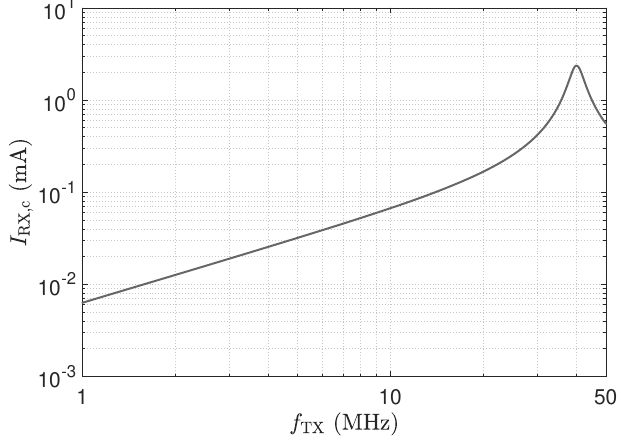
Figure 7. Frequency response of the current for the LCR input stage shown in Figure 4c. Component values stated in [30] were used to obtain a resonant frequency of 40MHz. The LCR circuit has a quality factor Q of 9.6. An excitation voltage V TX of 1V is applied, C X = 1pF, C s0 = C s1 = 10pF.